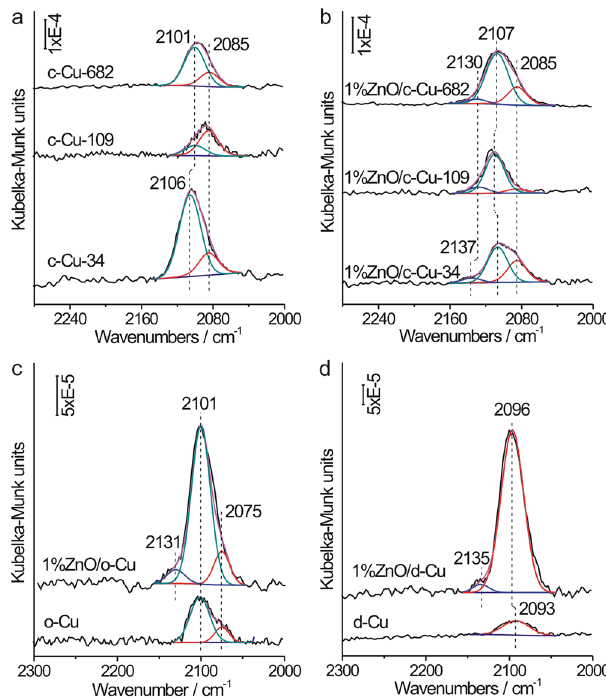
Fig. 2 Spectroscopic characterizations. In situ DRIFTS spectra of CO adsorption ((P CO = 400 Pa)) at 123 K on a various c-Cu NCs, b various 1% ZnO/c-Cu catalysts, c o-Cu NCs and 1%ZnO/o-Cu catalyst, and d d-Cu NCs and 1%ZnO/d-Cu catalyst. The red, green and blue lines represent the fi tted vibrational peaks of CO adsorbed on the Cu terrace sites of various facets, defective Cu sites and Cu(I) sites of Cu(I)-O-Zn interface, respectively.